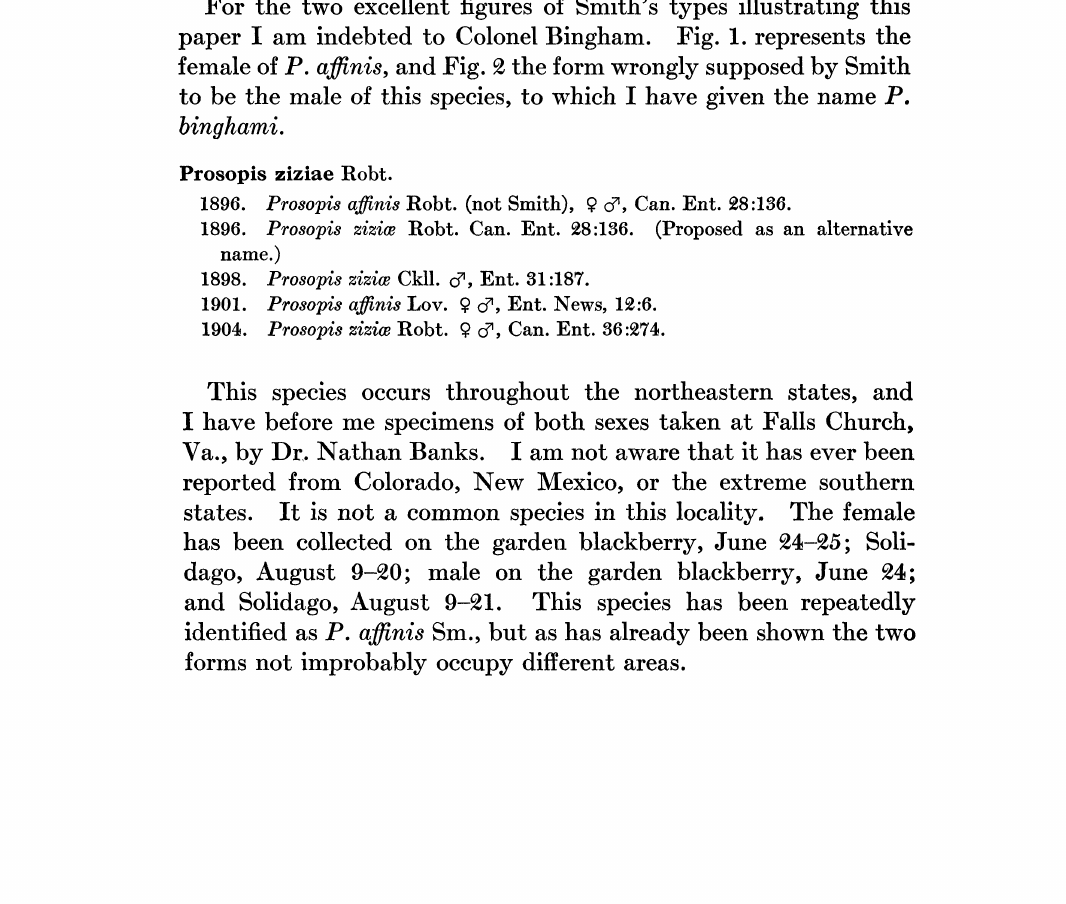
Fig. 1. represents the